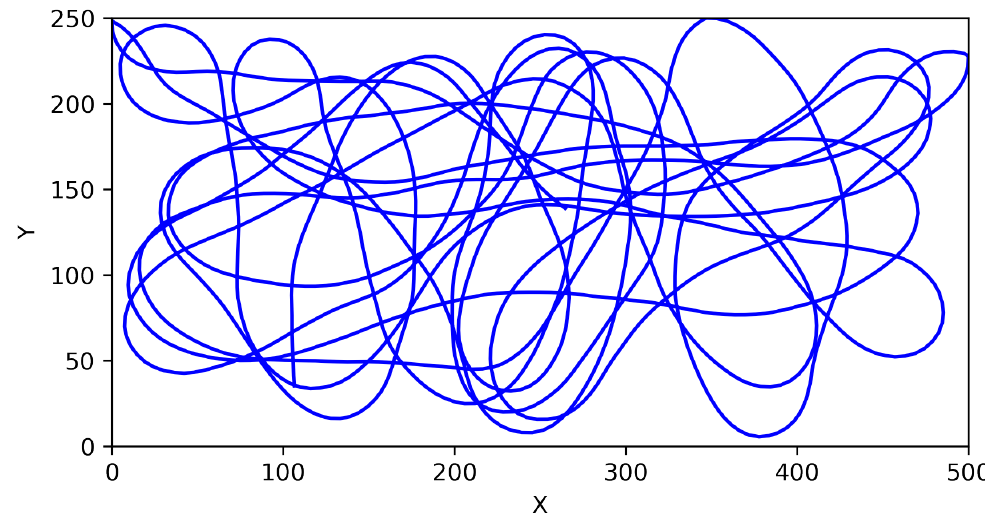
Figure 3. Drone trajectory in 2D using